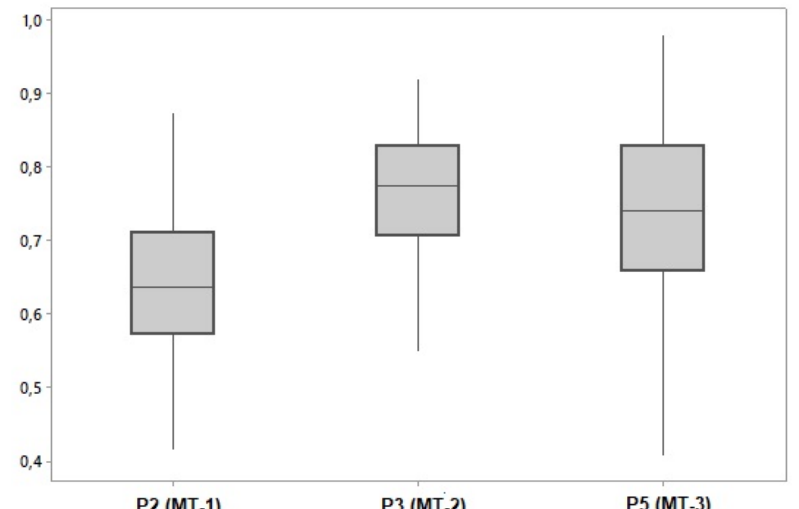
Figure 7. Boxplot with the size of the pores of the distinct levels of marine terraces. MT: marine